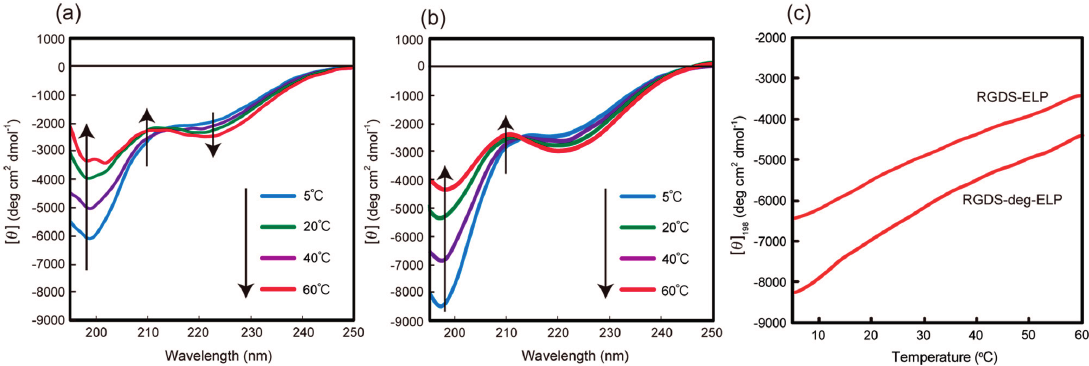
Figure 2. Temperature-dependence of circular dichroism (CD) spectra of ( a ) RGDS-ELP and ( b ) RGDS- deg -ELP in 5 mM citric/phosphate buffer (containing 5% TFE) at pH 7.4. [peptide] = 50 μ M. ( c ) Temperature profiles of [ θ ] 198 values for RGDS-ELP and RGDS- deg -ELP at heating